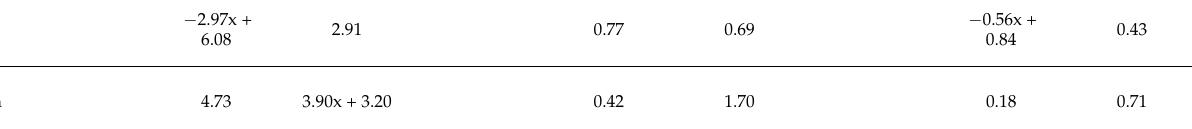
line has only a significant intercept, then the mean is reported, else the regression line equation is reported with variable x as the elevation of the site is in km (0–1.045). b Trend is from Sen’s Slopes.